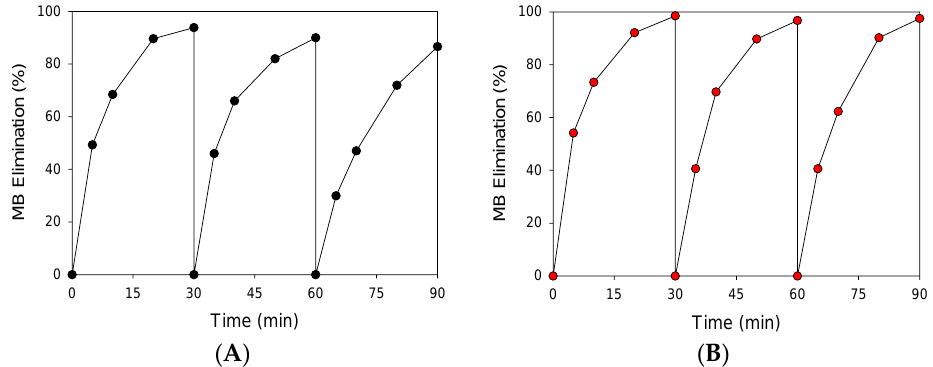
Figure 4. MB elimination (20 mg/L each cycle), using the same photocatalyst in three cycles (800 mg/L) ( A ). MB elimination (40 mg/L each cycle), using the same photocatalyst in three cycles (800 mg/L), and adding 0.3 mg/ml of H 2 O 2 ( B ).